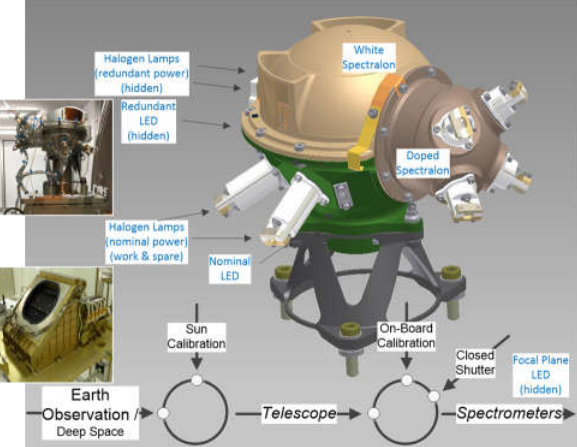
Figure 1. Calibration equipment on the satellite. (Image by OHB System